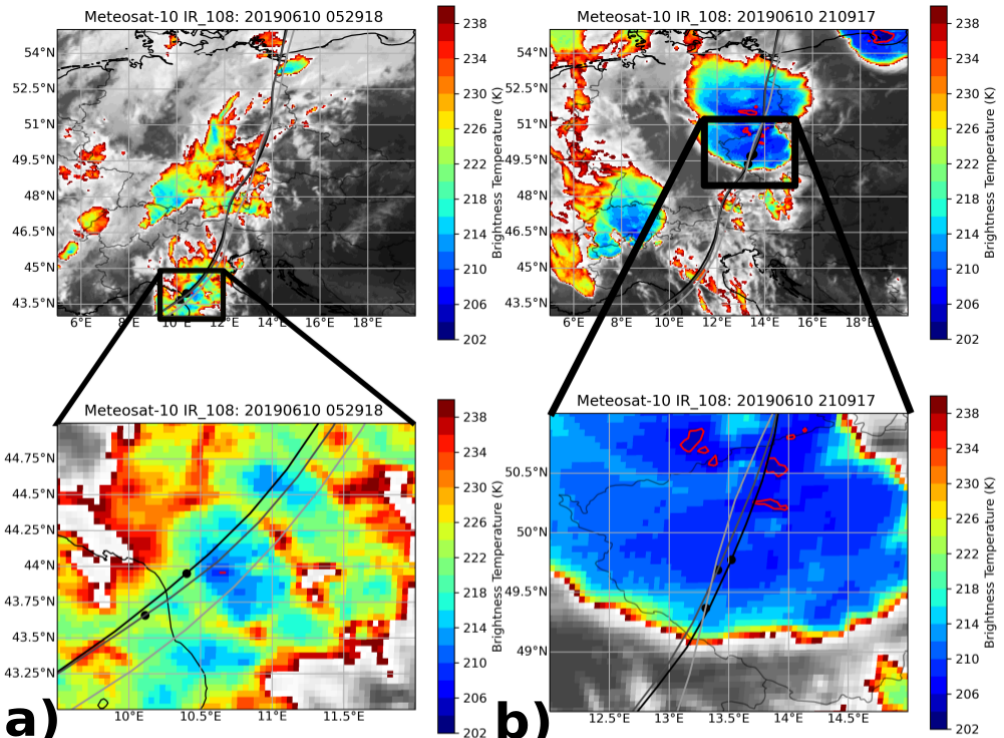
Figure 11. Brightness temperatures from geostationary Meteosat-10 satellite using the IR 10.8µm channel along trajectories for case 1 during two different times ( a at 05:59UTC and b at 21:09UTC on 10 June 2019). Air mass trajectories initiated at different pressure levels (149, 155, and 165hPa) are shown with gray to black lines. Air masses with BT < 205K are depicted with pink